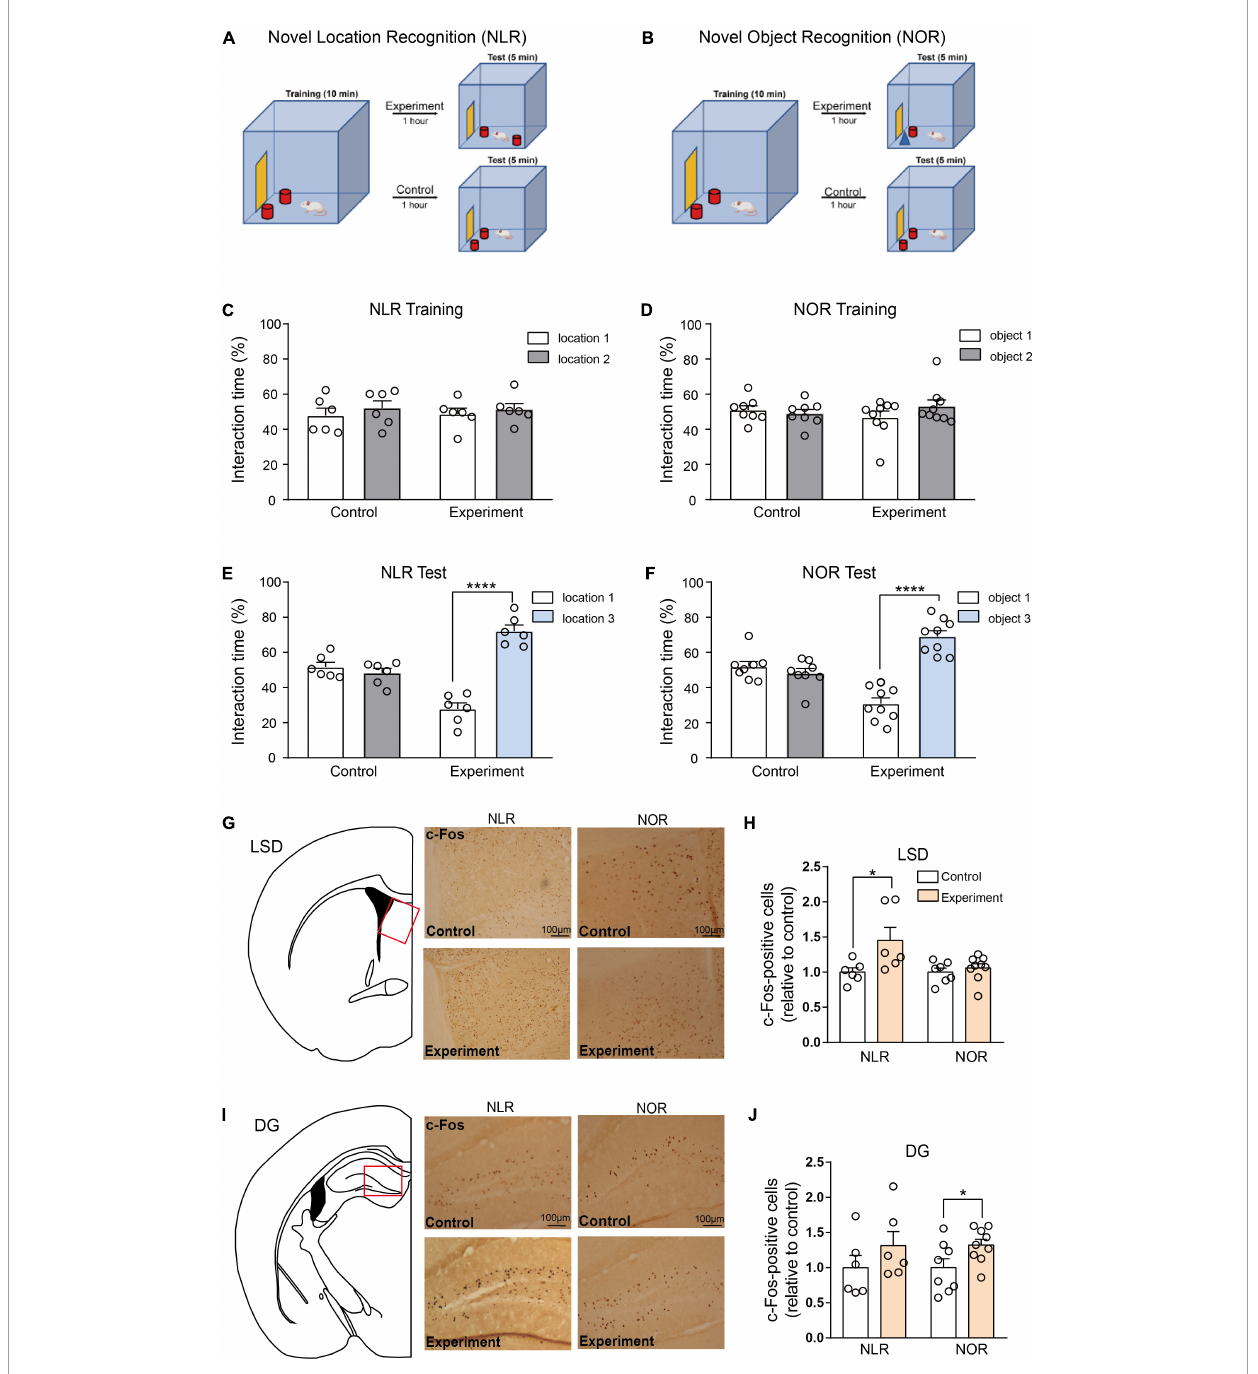
FIGURE2 Lateral septal nucleus, dorsal part (LSD), and dentate gyrus (DG) involved in the regulation of novel location recognition (NLR) and novel object recognition (NOR), respectively. (A,B) The diagram of NLR and NOR tests. During the training phase, the mice explored two identical objects for 10 min. During the test phase, 1 h later, one of the objects was changed into a new object/location. The experimental mice were allowed to explore two distinct objects/locations for 5 min each. The control mice were still exposed to the same objects/locations as in the training phase. (C) The interaction time (%) of NLR during the training phase in control and experiment groups ( n = 6 for each group). Unpaired t -test: control: t ( 10 ) = 0.7176, p = 0.4894; experiment: t ( 10 ) = 0.5592, p = 0.5884. (D) The interaction time (%) of NOR during the training phase in the control ( n = 8) and experiment group ( n = 9). Unpaired t -test: control: t ( 14 ) = 0.6287, p = 0.5397; experiment: t ( 16 ) = 1.269, p = 0.2227. (E) The interaction time (%) of NLR during the test phase in the control and experiment groups ( n = 6 for each group). Unpaired t -test: control: t ( 10 ) = 0.9233, p = 0.3776; experiment: t ( 10 ) = 9.113, **** p < 0.0001. (F) The interaction time (%) of NOR during the test phase in control ( n = 8) and experiment groups ( n = 9). Unpaired t -test: control: t ( 14 ) = 0.9937, p = 0.3373; experiment: t ( 16 ) = 8.233, **** p < 0.0001. (G) Representative images of c-Fos positive cells in the LSD of control and experiment mice in NLR and NOR tests. Scale bar, 100 µ m. (H) Quantification of c-Fos positive cells in the LSD of control and experiment mice in NLR and NOR tests (NLR: n = 6; NOR: n = 8). Unpaired t -test: NLR: t ( 10 ) = 2.312, * p = 0.0434; NOR: t ( 14 ) = 0.7066, p = 0.4914. All the data conformed to normality. (I) Representative images of c-Fos positive cells in the DG of control and experiment mice in NLR and NOR tests. Scale bar, 100 µ m. (J) Quantification of c-Fos positive cells in the DG of control and experiment mice in NLR and NOR tests (NLR: n = 6; NOR: n = 8). Unpaired t -test: NLR: t ( 10 ) = 1.177, p = 0.2663; NOR: t ( 15 ) = 2.202, * p = 0.0437. All the data conformed to